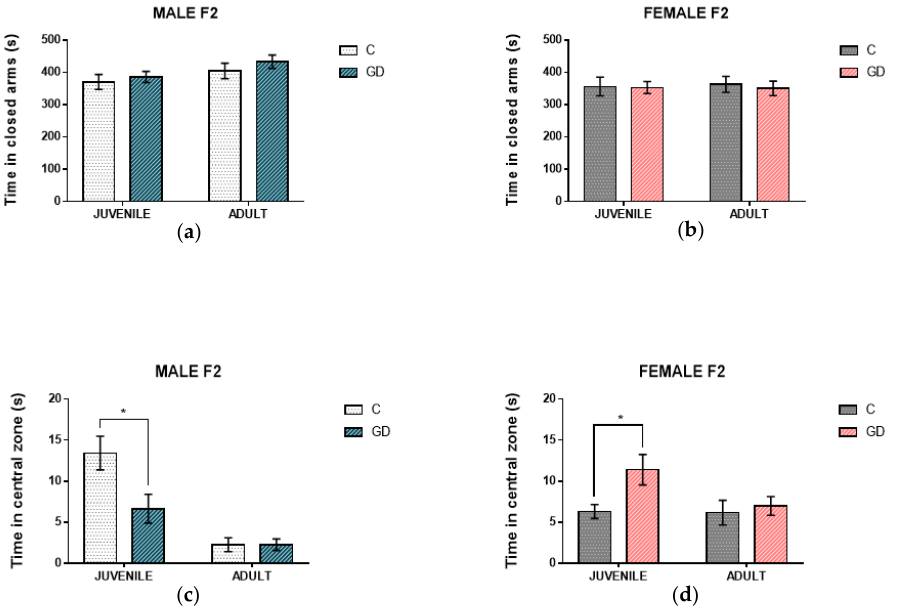
Figure 1. Effect of GD on the anxiety-like behavior of the second-generation offspring. The upper panel shows the time spent in the closed arms of elevated plus maze: juvenile and adult male offspring ( a ) and female offspring ( b ). The lower panel shows the time they spent in the central zone of the open field; ( c ) shows the male offspring and ( d ) the female offspring at juvenile and adult age. C, offspring of control rats; GD, offspring of rats with gestational diabetes, n = 10 to 12. The data are expressed as the mean ± SEM. Student’s t -test, * p <